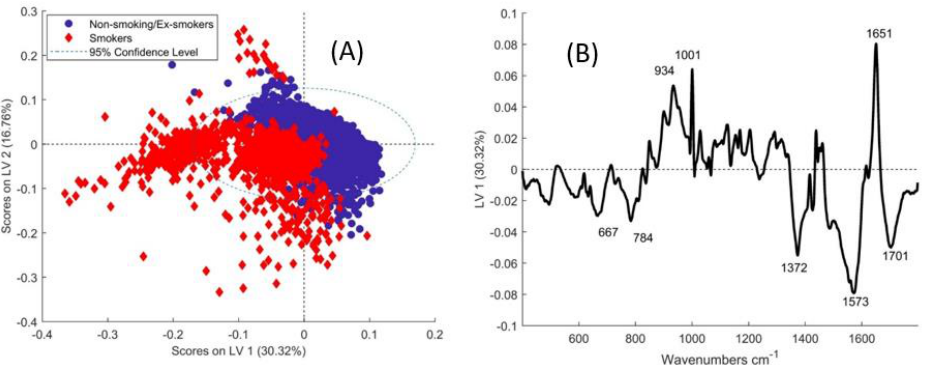
PLSDA model. ( B ) Loading of LV-1 from PLSDA of smokers vs non-smoker and ex-smokers in epithelial